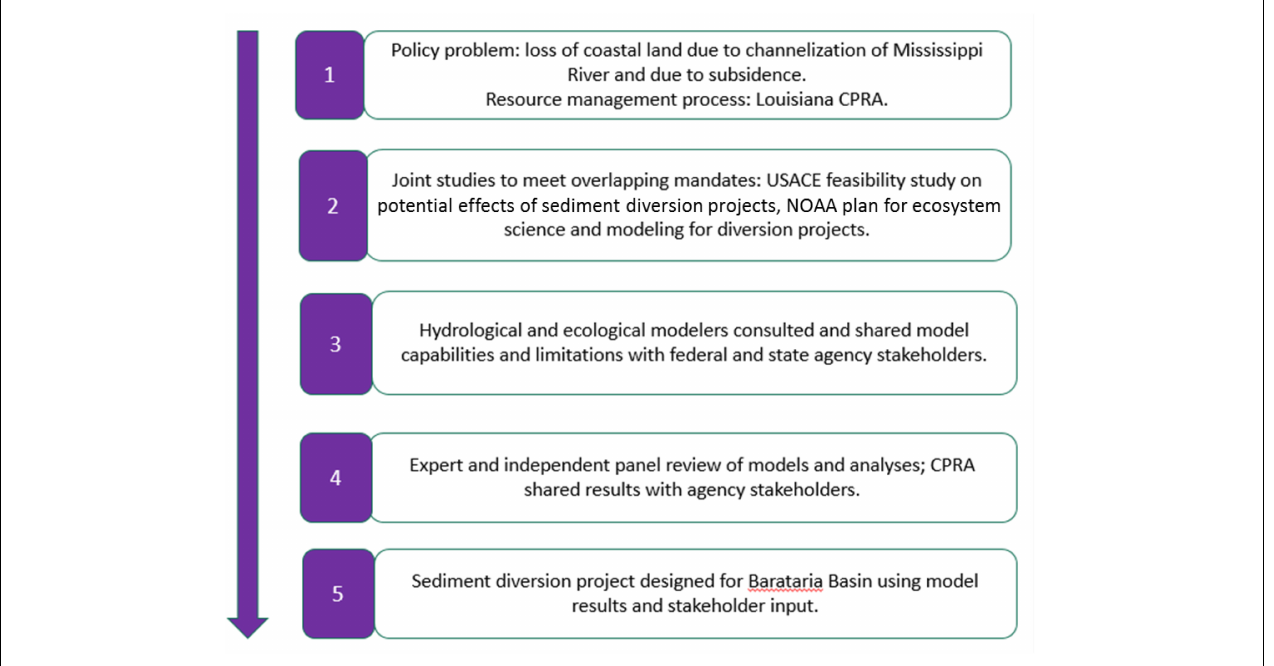
FIGURE 5 | Coastal Louisiana Restoration Case Study